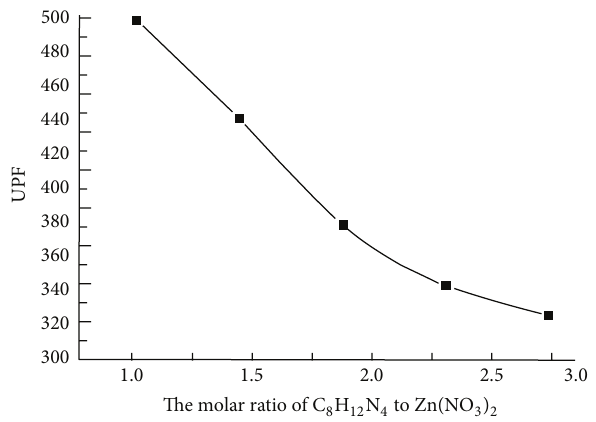
Figure 3: The effect of molar ratio between C 8 H 12 N 4 and Zn(NO 3 ) 2 on UV blocking property of fabric (reproduced with the permission from